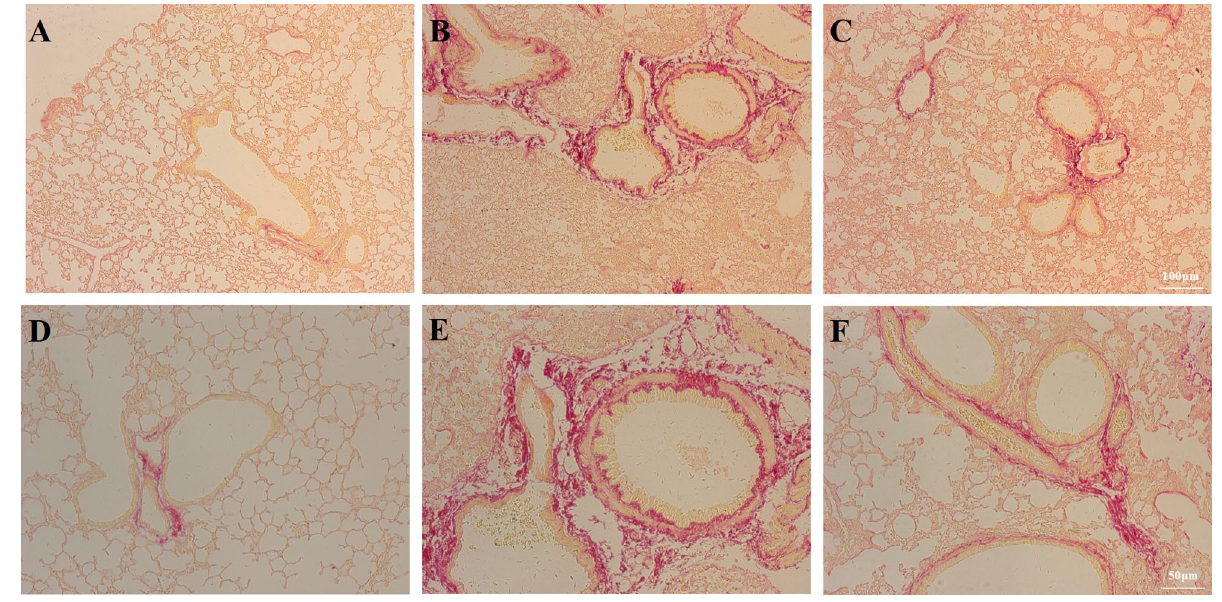
Figure 8. BM-MSCs improved LPS-induced pulmonary fibrosis in the airway wall at 24 h after LPS treatment. ( A ) Sham group. ( B ) LPS group. ( C ) LPS + MSC group. Sirius Red staining was performed to identify collagen fiber deposition in the airway wall. ( A – C , ×100 magnification. D – F , ×200 magnification).